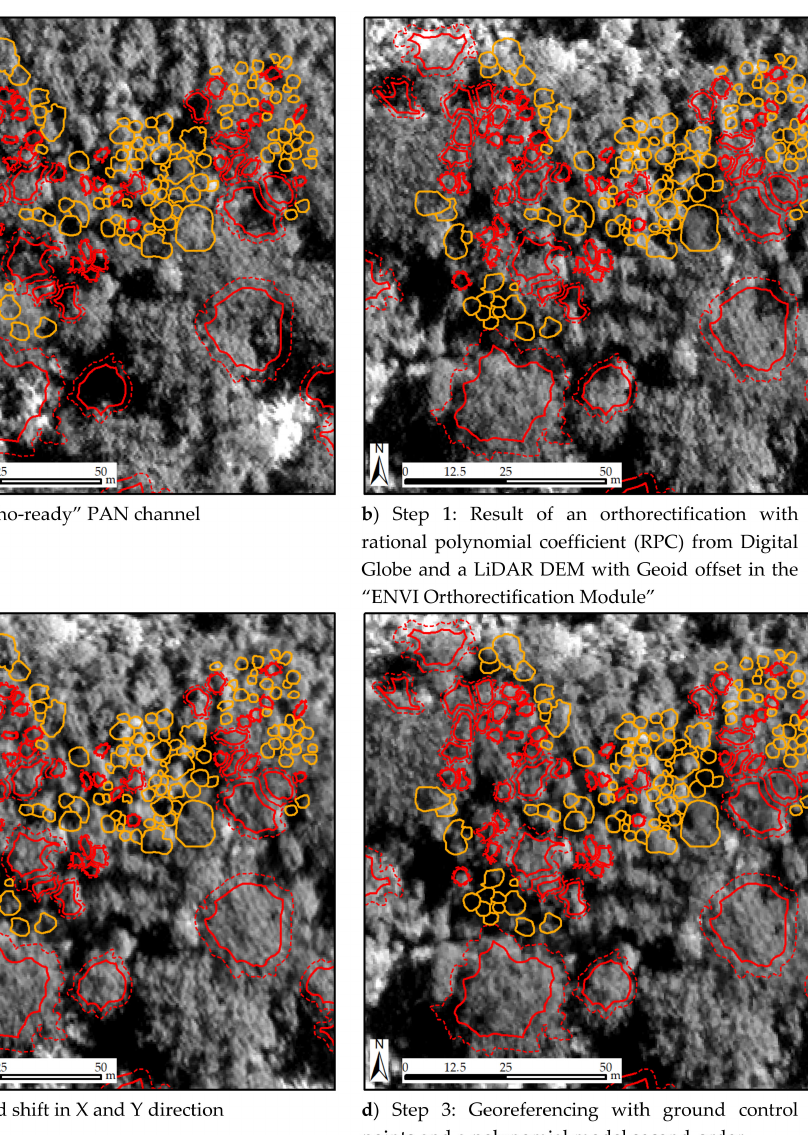
Figure A1. Di ff erent steps in the orthorectification illustrated with the PAN channel of the WorldView-2 image, for a forest section in the Cascade area. The red polygons mark crowns of kauri and dead / dying trees that were used in the analysis. The 10% bu ff er, which was removed for the analysis, is marked with a stippled line. The orange polygons mark crowns from other species and kauri smaller than 3 m diameter that were not used in this